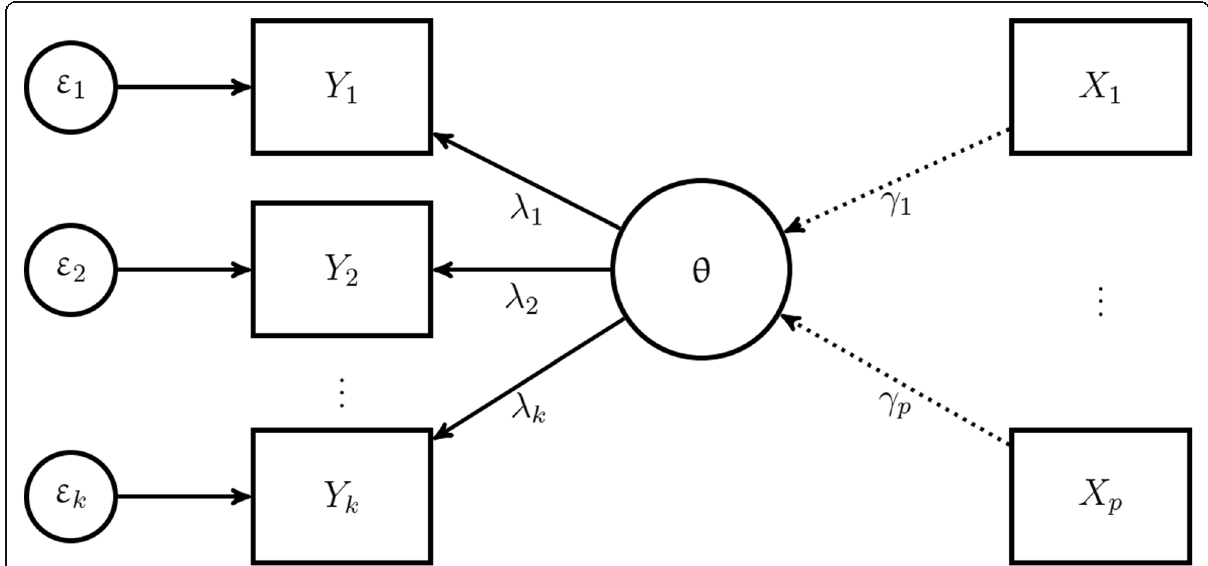
Fig. 1 A latent measurement model in CTT notation. The latent ability θ is measured by k test items (manifest indicators Y 1 … Y k ). The different loadings λ 1 … λ k and measurement error terms ε 1 … ε k reflect different degrees to which each item reflects the latent ability. For substantive analyses and/or for estimating PVs, θ can be predicted by background variables ( X 1 … X p ). The latter model part is often referred to as the population model (e.g., Mislevy,